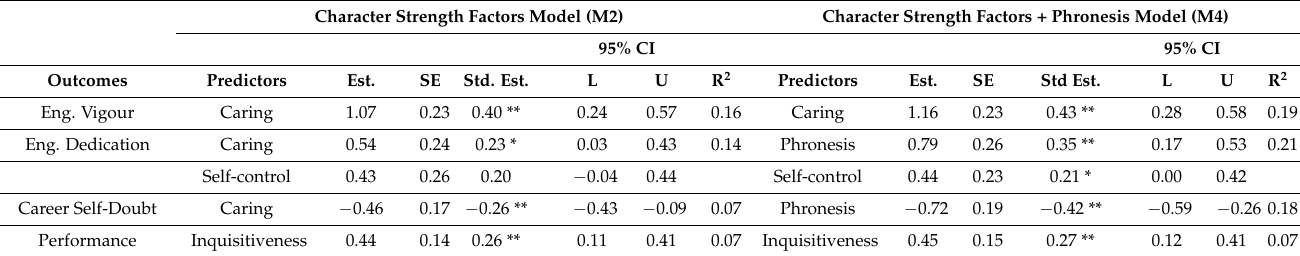
Table 3. SEM regression paths of Character Strength factors and Phronesis Motivation predicting Academic